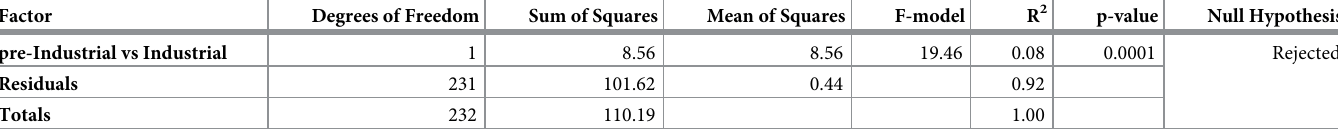
Table 4. Results of the one-way permutational multivariate analysis of variance (PERMANOVA) assessment of the relationship between period and lower second molar wear facet area composition. The dependent variables being tested are buccal phase I, lingual phase I and phase II wear facet area and the independent variable is the two modern human groups (either pre-industrial or